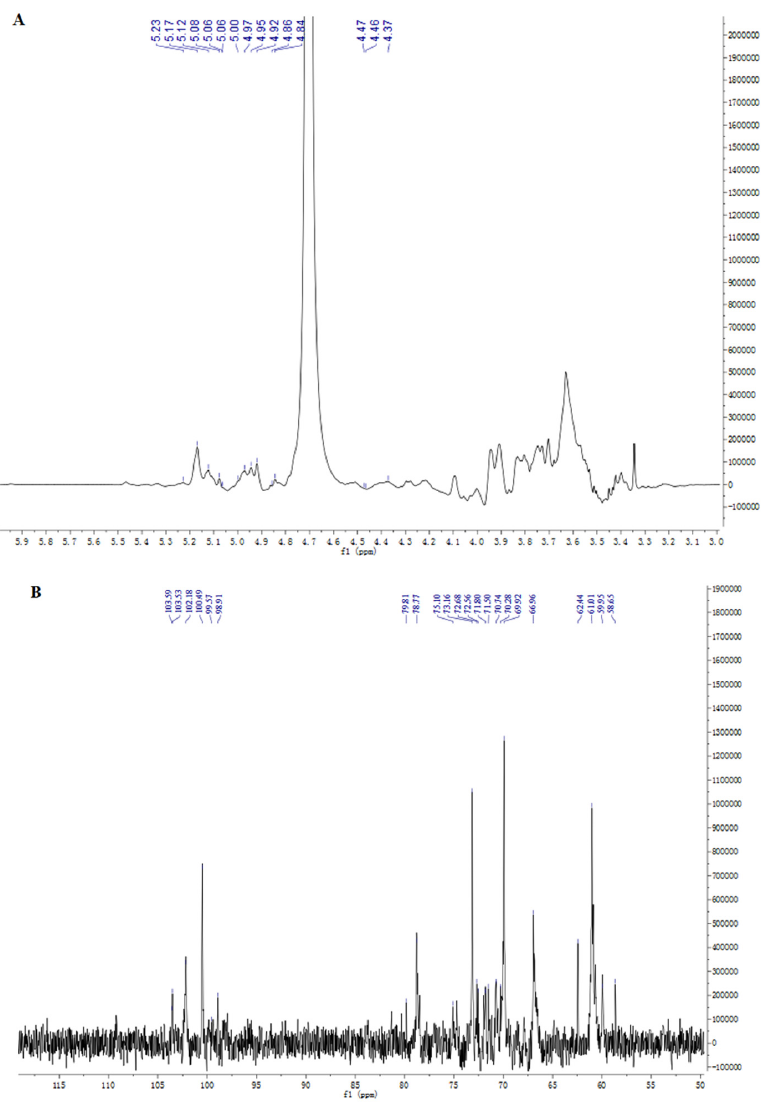
Figure 4. One − dimensional NMR analysis of EPS2-1. ( A ) 1 H spectrum; ( B ) 13 C spectrum. Residue B had an anomeric signal at δ 5.23/101.95 ppm in the HSQC spectrum, 1 H- 1 H COSY spectrum showed a cross peak of H-1 with H-2 ( δ 4.01 ppm). The chemical shift of C-2 was assigned to be δ 80.21 ppm in HSQC spectra. Similarly, δ 3.88/71.32, 3.6/68.19, and 3.7/74.5 ppm were classified as H3/C3, H4/C4, H4/C4, and H5/C5, respectively. The carbon signal at δ 80.21 ppm was attributed to the C-2 signal of the (1 → 2)-linked mannose, therefore, residue B was identified to be → 2)- α -D-Man p -(1 → . The chemical shift of C-6 was shifted to a lower field ( δ 67.2 ppm) compared to the unsubstituted C-6, indicating that residue E was → 6)- α -D-Manp-(1 → . The chemical shift of the heterotopic carbon of residue D was δ 104.49 ppm, which indicated that residue D contained β -D-Gal p. At the same time, the downfield chemical shifts of C-3 and C-6 showed that residue D was → 3,6)- β -D- Galp-(1 → (Figure 5A,B). Based on the monosaccharide composition, methylation analysis, and literature reports, the primary signal attributions of glycosidic residues in EPS2-1 are shown in Table 3